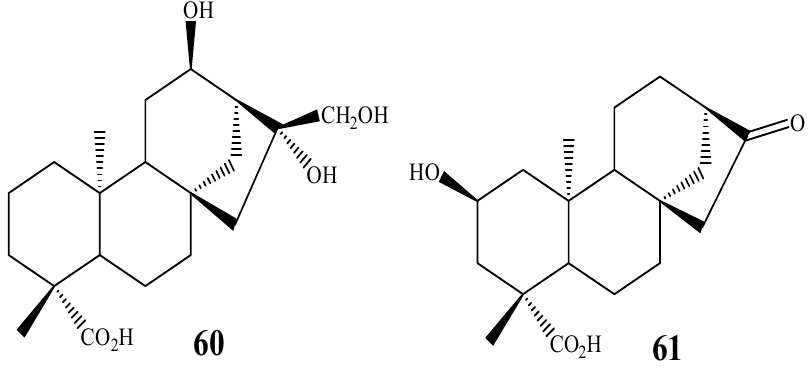
Figure 15. Chemical structures of kaurane diterpenes bearing C-12 and C-2